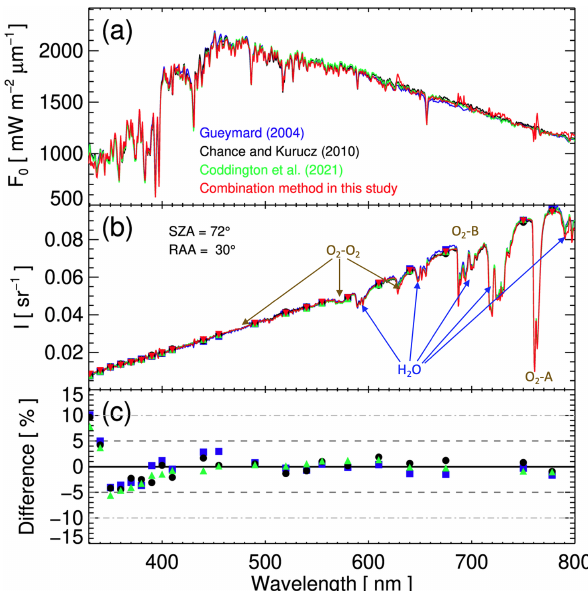
Figure 3. (a) An example of the nine-lamp Grande voltage count measurements from SMART–s (Pandora no. 48) without neutral density or bandpass filters. All 10 colors are plotted as in Fig. 2, indicating the average current measurements over 10 repetitions, which overlap almost completely. Panel (b) is the calibration coeffi- cient, which is calculated from dividing the known Grande intensity by the average value of the measured voltage count. Panel (c) is the precision of the calibration coefficient, which is estimated by calcu- lating 1 standard deviation of the repetitions done 10 times.